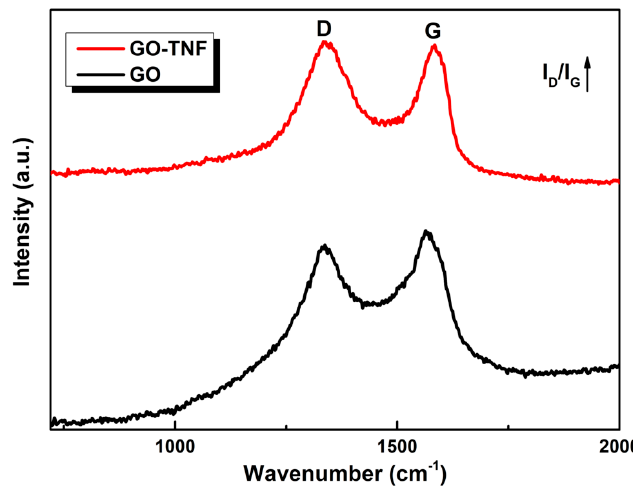
Figure 5. Raman spectra of GO and GO-TNF.